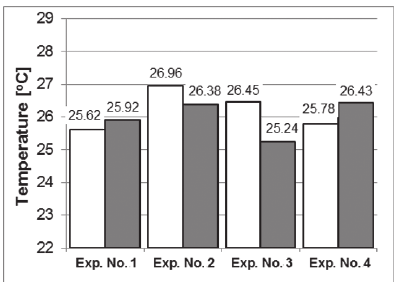
Fig. 4a. Results of calculation and measurement of average temperature of ventilated air gap ( white – calculation, black – measured